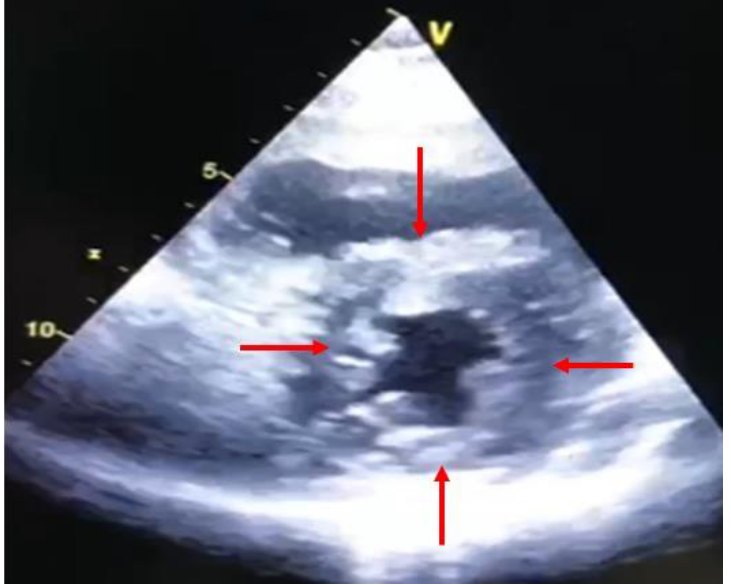
Figure 1. Short-axis view at trans thoracic echocardiography two months after heart transplantation. Note the concentric and symmetric hypertrophy of the left ventricle (red arrows).